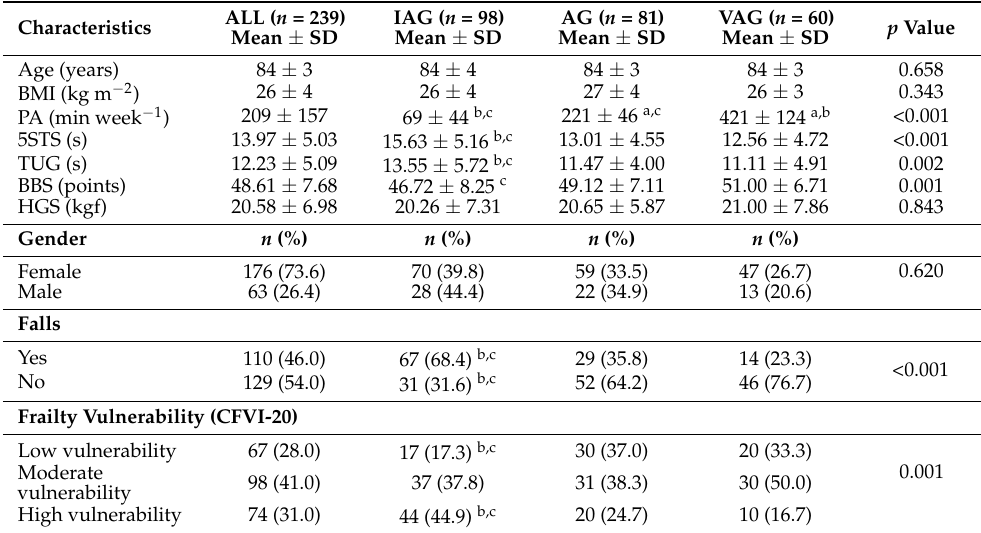
Table 2. Comparison of physical characteristics, frailty, vulnerability, functional capacity, and falls of all participants (ALL) and between insufficiently active (IAG), active (AG), and very active (VAG) groups.